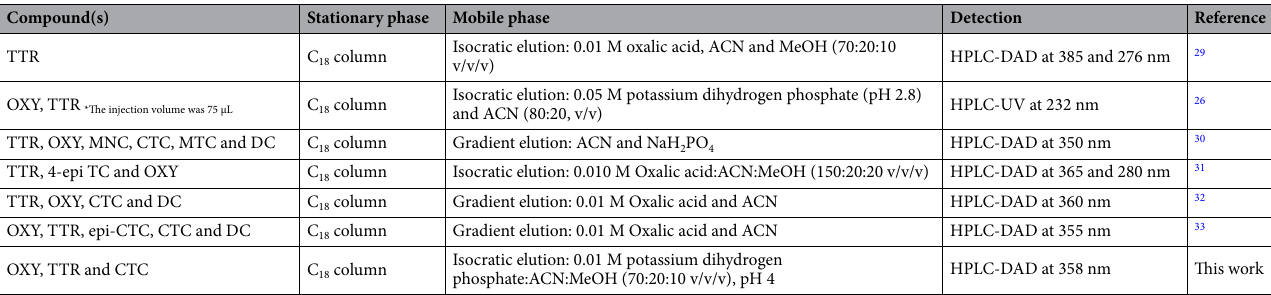
Table 1. Determination methods of tetracycline antibiotics residues in milk samples by HPLC-DAD. OXY Oxytetracycline, TTR tetracycline, CTC Chlortetracycline, MTC Methacycline, MNC Minocycline,